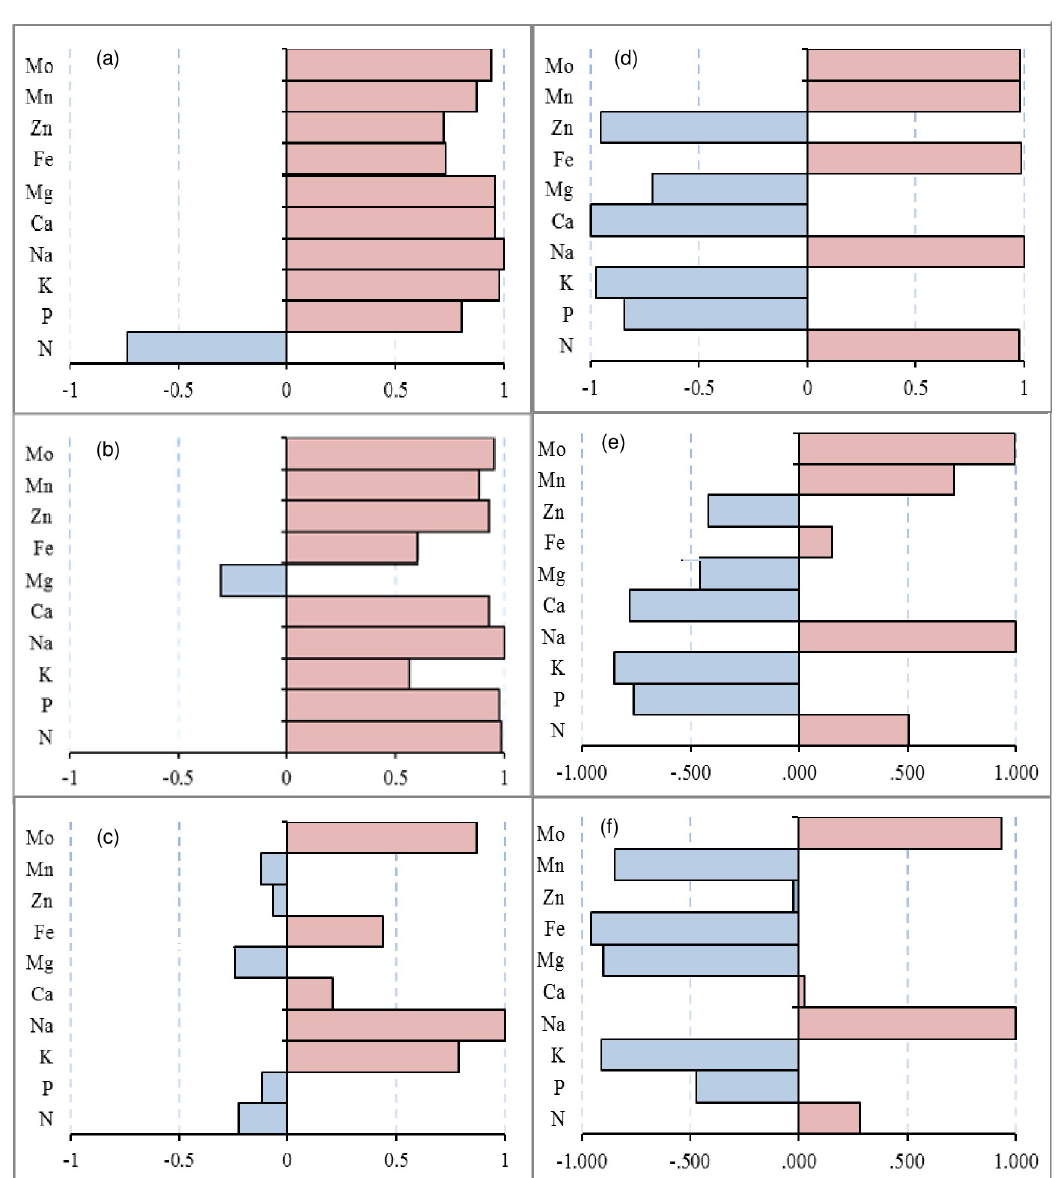
Fig 5. Correlation between the concentration of Na and other elements in leaves, stem, and root of two cotton varieties (salt- tolerant variety L24, salt-sensitive variety G1) under alkaline stress. (a), (b), and (c) stand for the leaves, stem, and root of L24, respectively; (d), (e), and (f) stand for the leaves, stem, and root of G1,